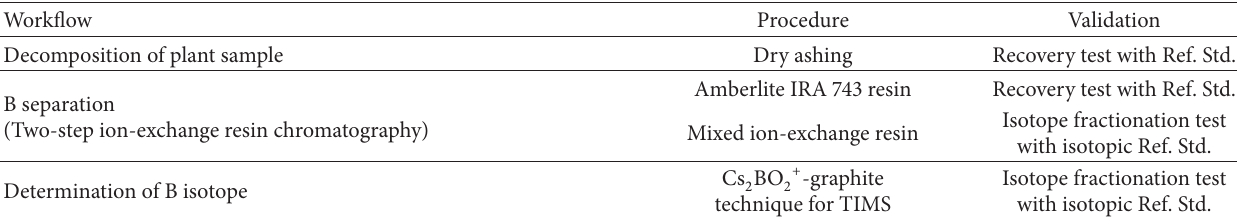
Table 2: Workflow of the separation of B in plant